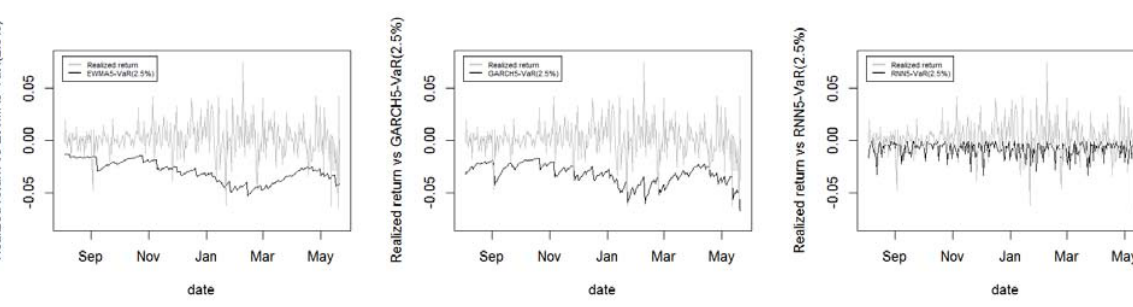
Figure A7. Out of sample realized return vs. 1 day ahead VaR (2.5%) of EWMA, GARCH and RNN model.